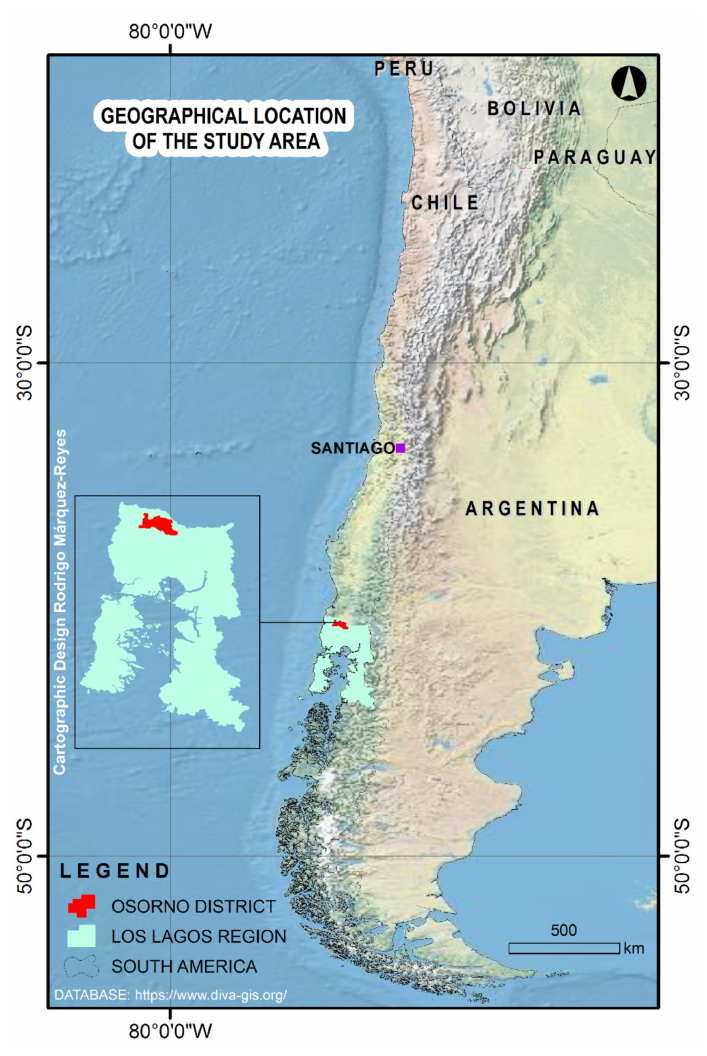
Figure 1. Geographical location of the study area. Bar, 500